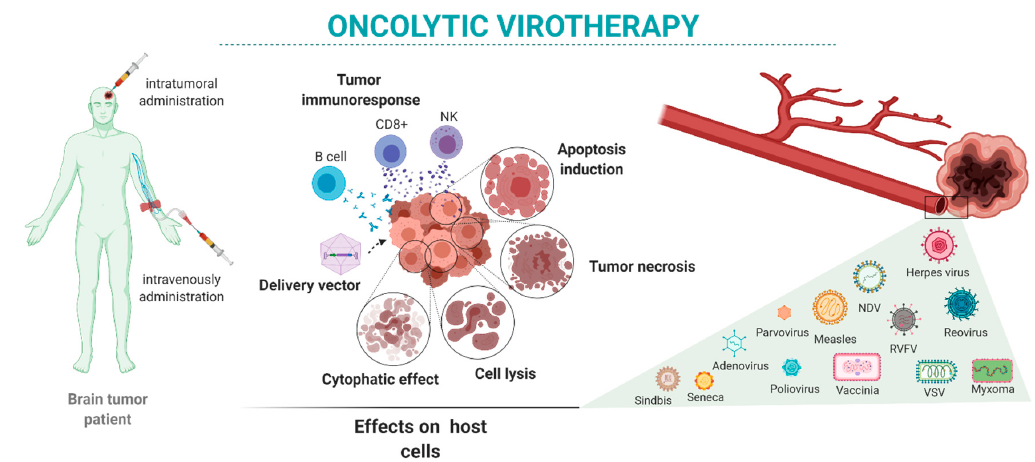
Figure 1. Oncolytic virotherapy in brain tumors: intratumor or systemic administration of oncolytic viruses may have different oncolytic reactivity once the virus reaches the target cells. Those effects depend on the characteristics of the tumor as well as the variety of available viruses and their characteristics.